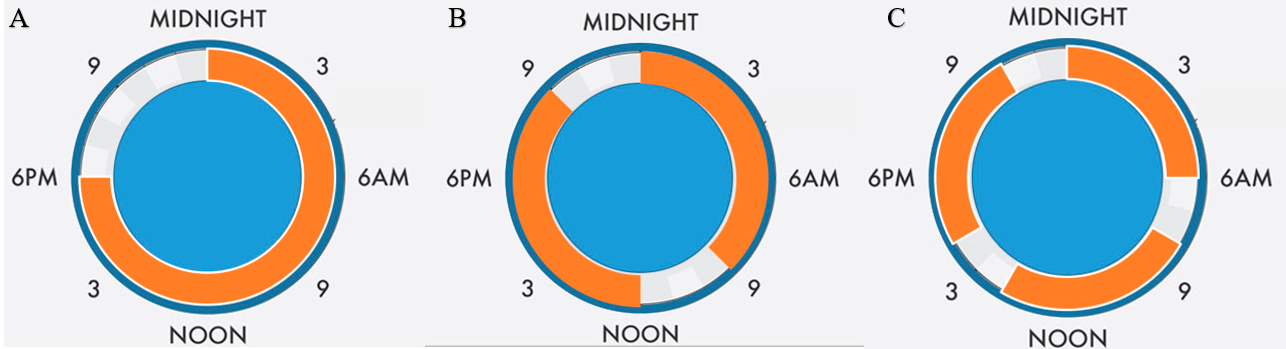
Figure 4. Examples for suggested fractionation schedules for TTFields treatment. In scenario ( A ), 18 h daily usage continuously and 6 h off time is illustrated. In scenario ( B ), 9 h usage and 3 h break time twice daily is illustrated. In scenario ( C ), 6 h usage and 2 h break times three times daily is illustrated.